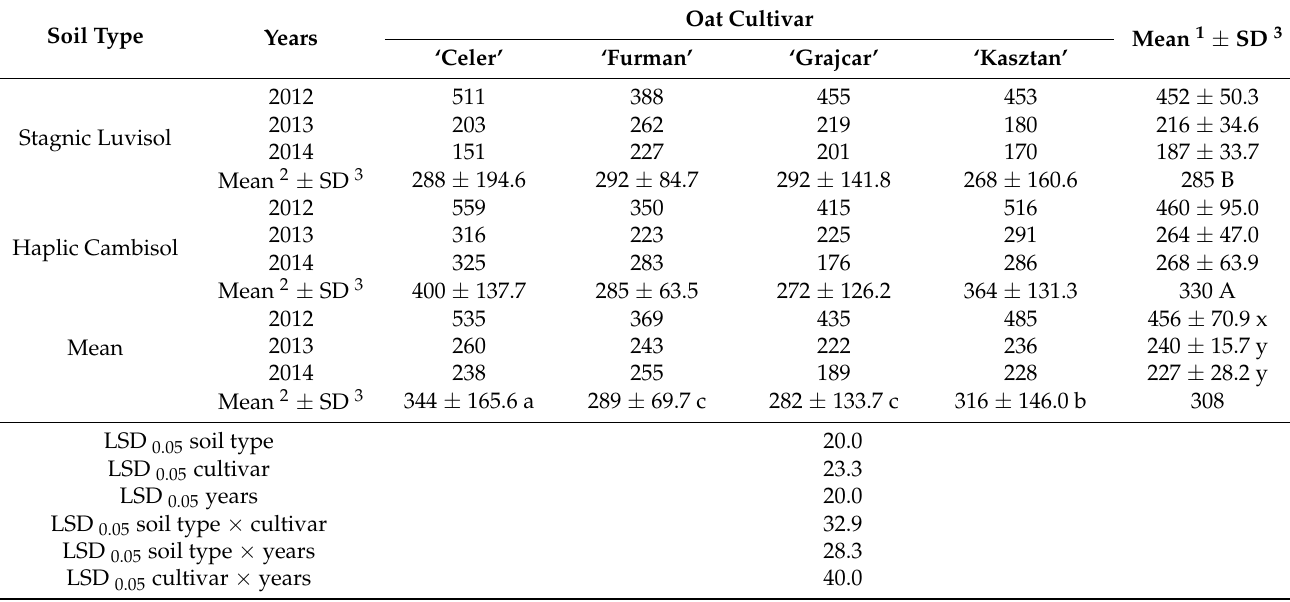
Table 10. Number of oat panicles (pieces m − 2 ) in the mixtures depending on the soil type (factor I), oat cultivar (factor II), and study years (factor III).